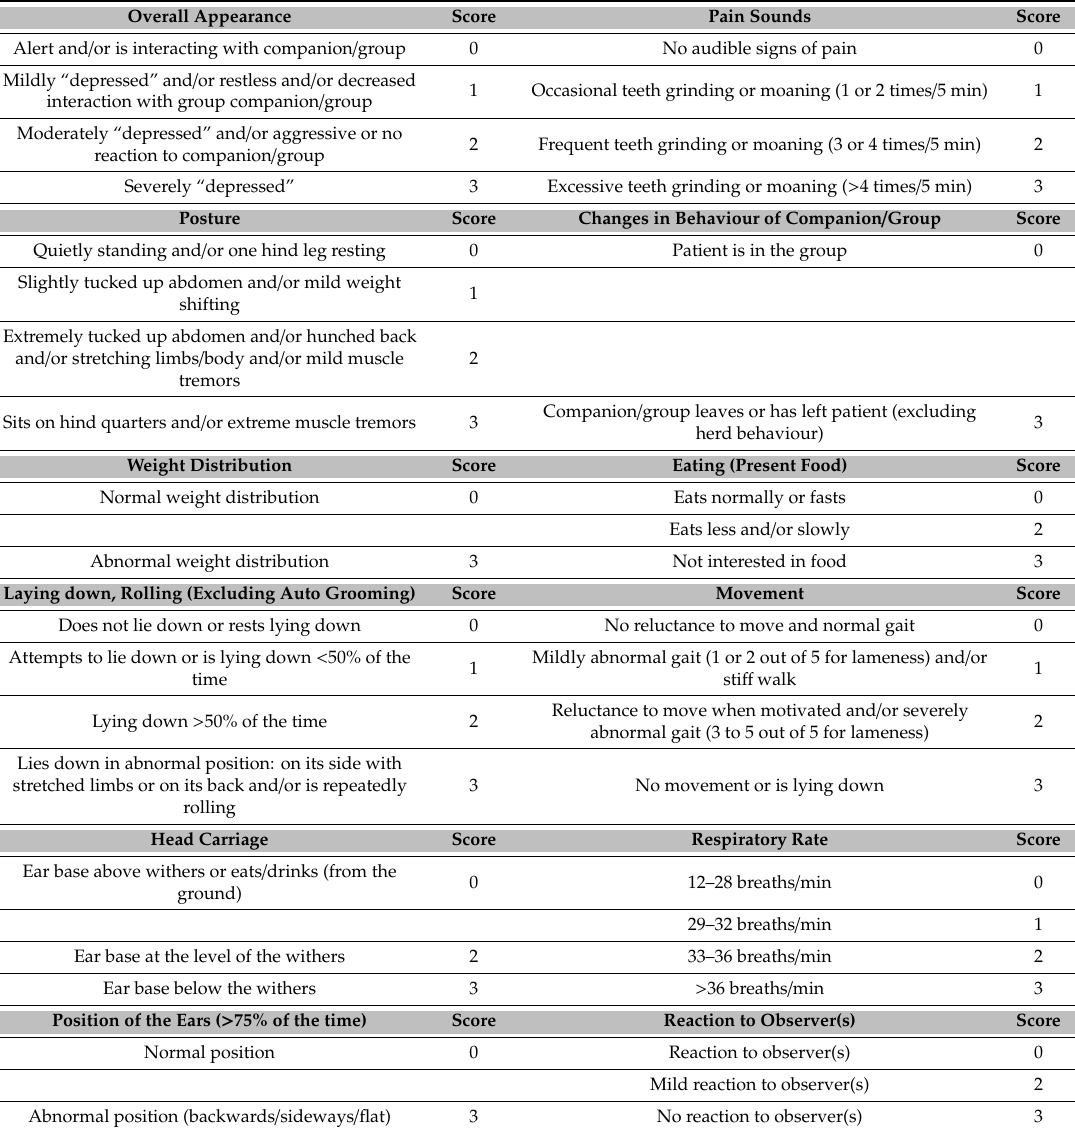
Table 2. The EquineUtrecht UniversityScale for Donkey CompositePain Assessment (EQUUS-DONKEY -COMPASS) score